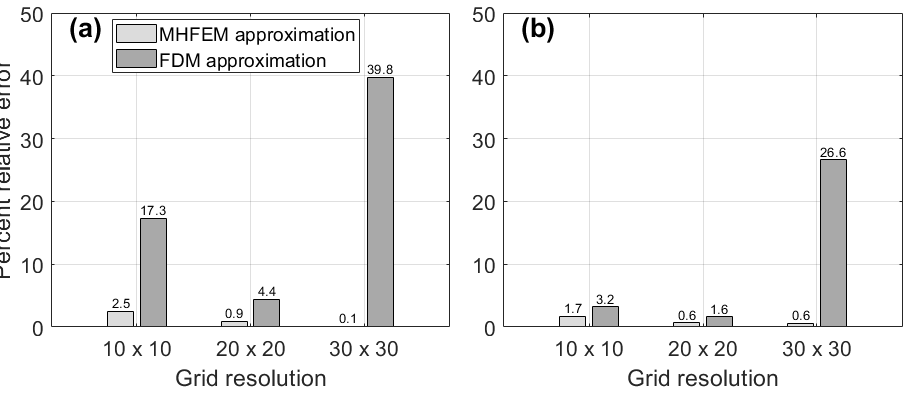
Figure 6. Calculated relative errors in simulated residence times of two particles released at (25, 100) ( a ) and (95, 100) ( b ) using the MHFEM and FDM approximations.